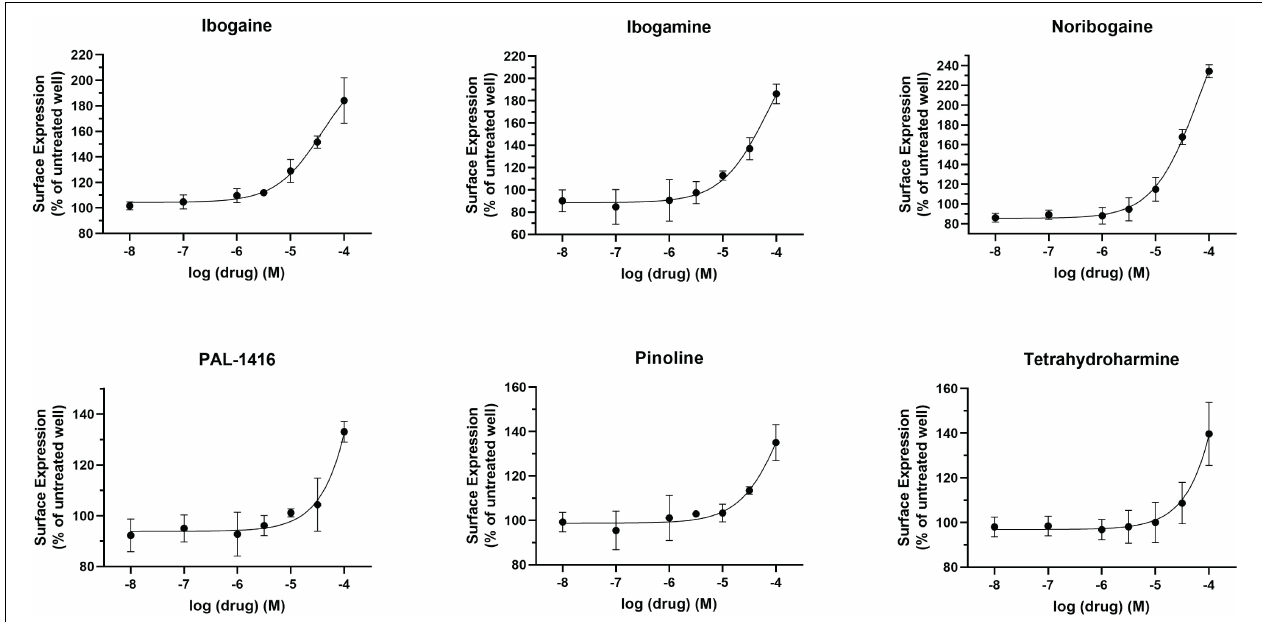
FIGURE 4 | Effect of overnight ibogaine analog treatment on YFP-HA- β lac-DAT surface expression. Dose-dependent curves for ibogaine analogs of interest. Data were normalized to vehicle treatment. Data were fitted to one-site dose-response non-linear regression curves using GraphPad Prism. Data are means ± S.E.M. n =